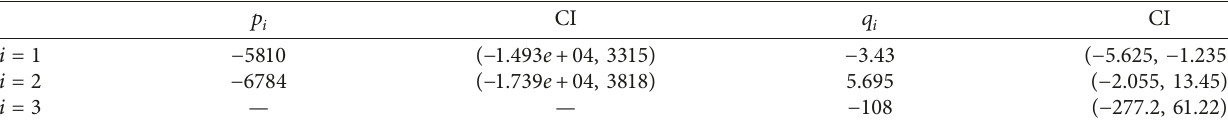
Table 25: GA vs. Entropy.